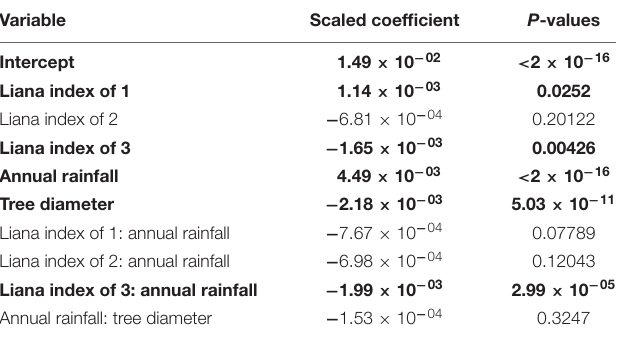
TABLE 1 | Results from linear mixed effects model relating tree growth to liana index, annual rainfall, and tree diameter. Variable Scaled coefficient P